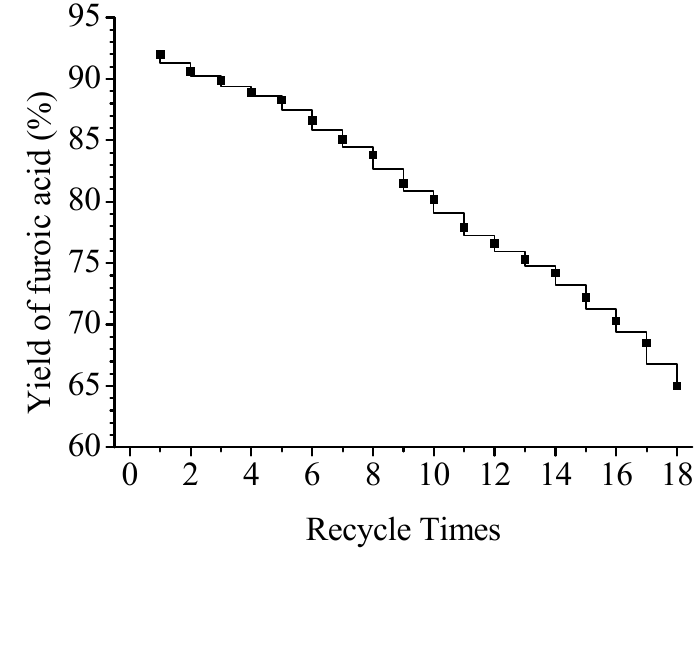
O/CuO recycling times on furoic acid 2